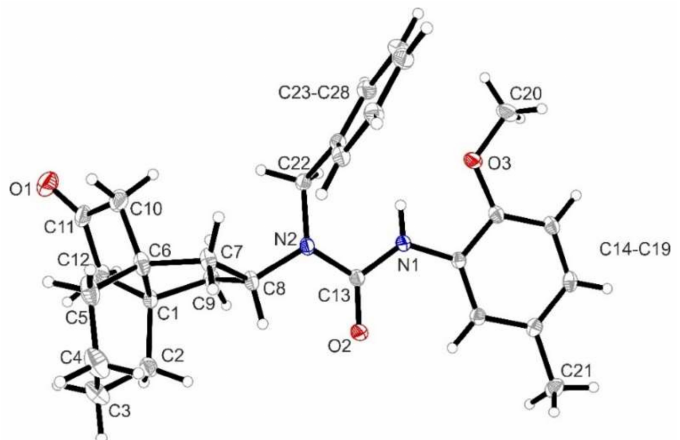
Figure 6. X-ray crystal structure of N -benzylurea anti - 21 . Thermal ellipsoids are set at 15% probability. Length of selected bonds: conjoining bond C1–C6 = 1.550(3) Å; C1–C2 = 1.523(4) Å; C1–C9 = 1.530(3) Å; C1–C12 = 1.548(4) Å. CCDC number: